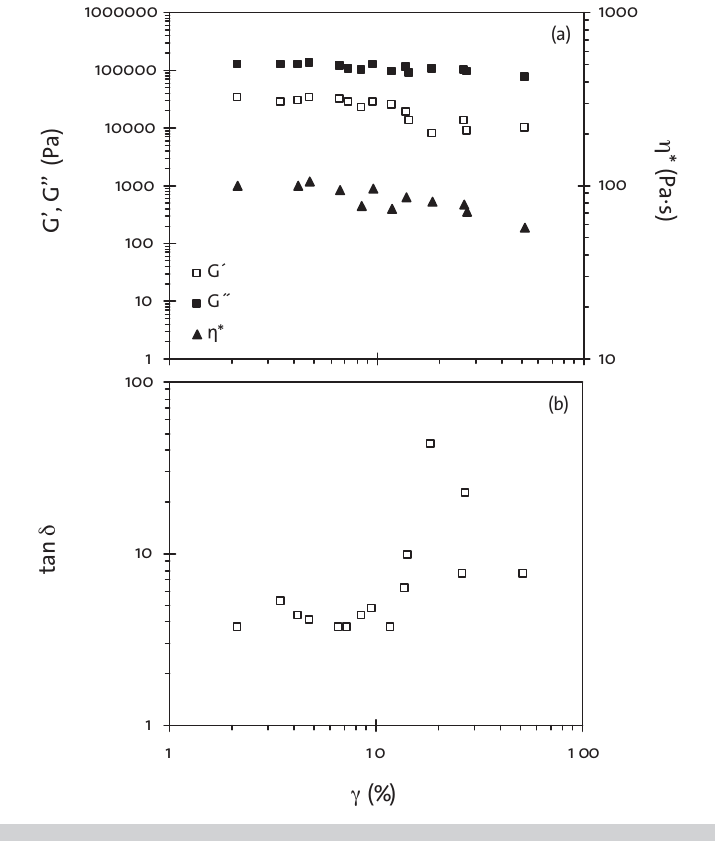
Figure 2 (left): A representative plot of the shear stress, s , and shear strain, g , as a function of time, t, for PB obtained on the HF- SPR (gap = 0.53 mm and amplitude = 0.0635 mm). Figure 3: a) Storage modulus, G’, loss modulus, G’’, complex vis- cosity, h *, and b) loss tangent,tan d , as a function of strain, g , for PB measured using the